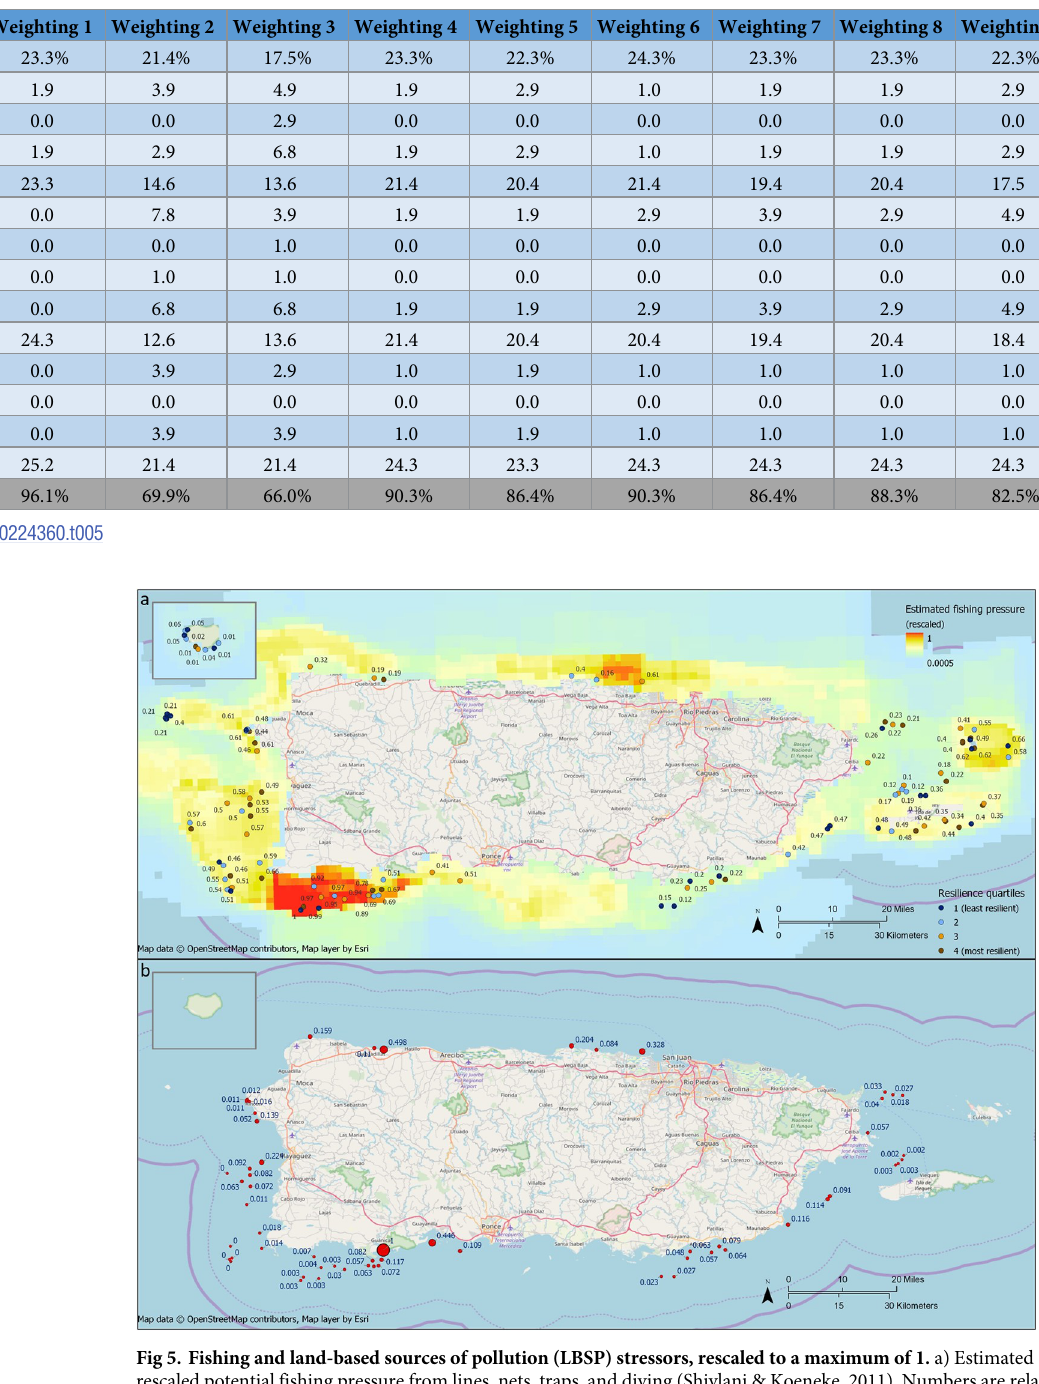
PLOS ONE | https://doi.org/10.1371/journal.pone.0224360 November5,